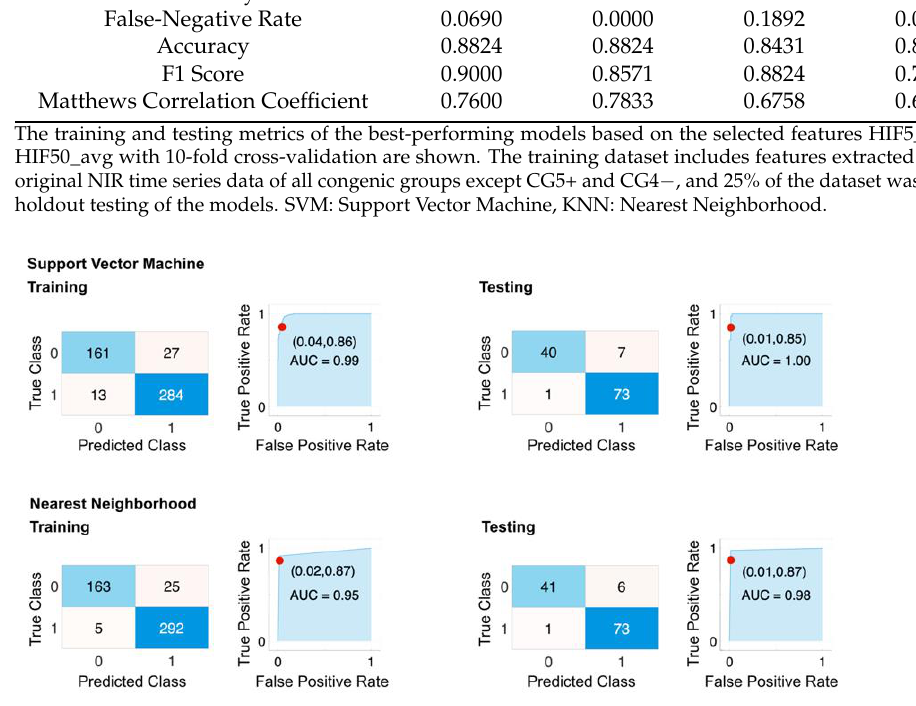
Figure 7. Performance of selected features on augmented dataset. The confusion matrix and ROC plots for training and testing of best-performing models based on HIF5_avg and HIF50_avg features with 10-fold cross-validation. The dataset includes all rat strains except Dll4+, Dll4 − , CG4 − , and CG5+. 25% of the dataset was used for holdout testing. Top row: SVM model. Bottom row: Nearest Neighborhood. Table 4. Performance of selected features on augmented dataset.